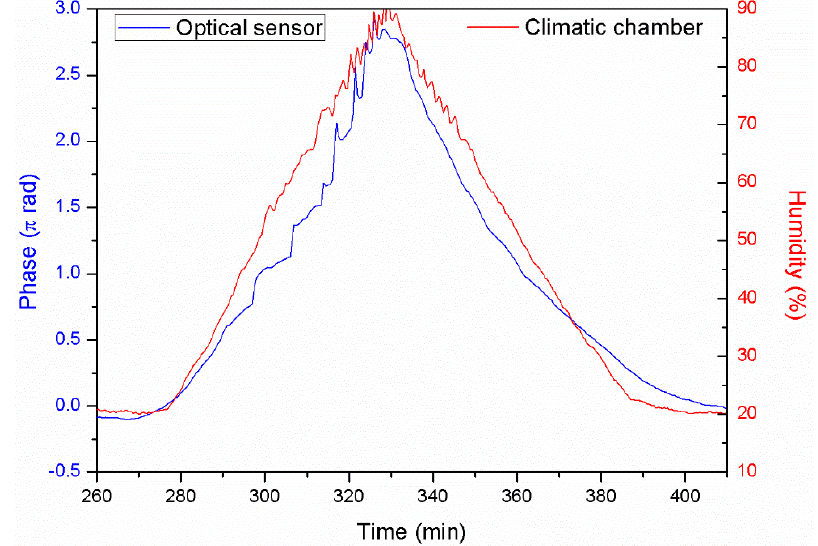
Figure 3. Calibration of the optical sensor.